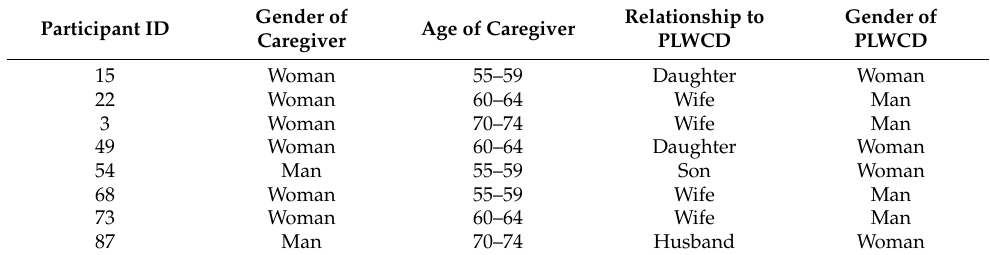
Table 1. Demographic characteristics of the participants in the study.